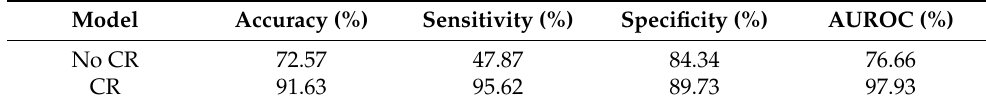
Table 4. Performance of the GBC model trained without CR and trained only with CR.